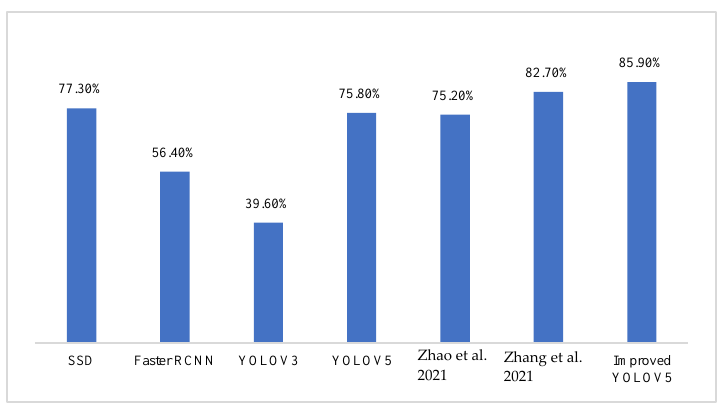
Figure 12. mAP of improved YOLOV5 and other methods [45,46].